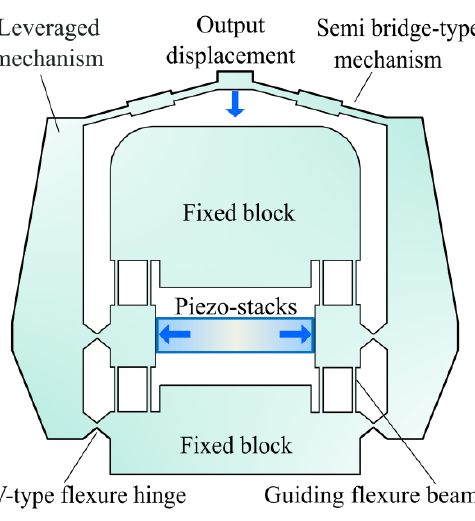
Figure 2. Schematic diagram of the presented hybrid two-stage displacement amplification mecha- nism by synthesizing lever-type and semi bridge-type compliant